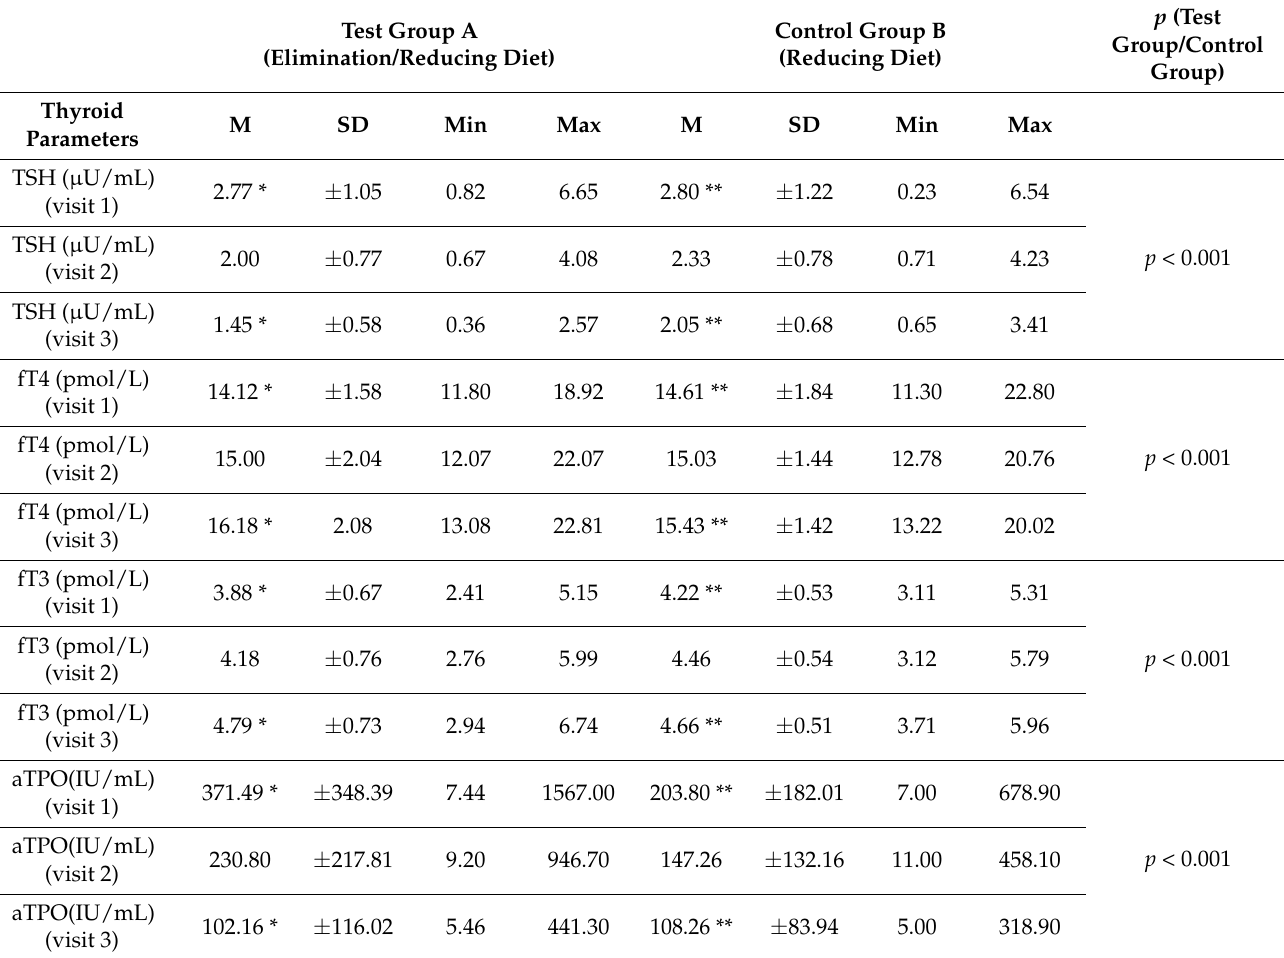
Table 2. Change in thyroid parameters in both groups depending on the nutritional intervention used. Test Group